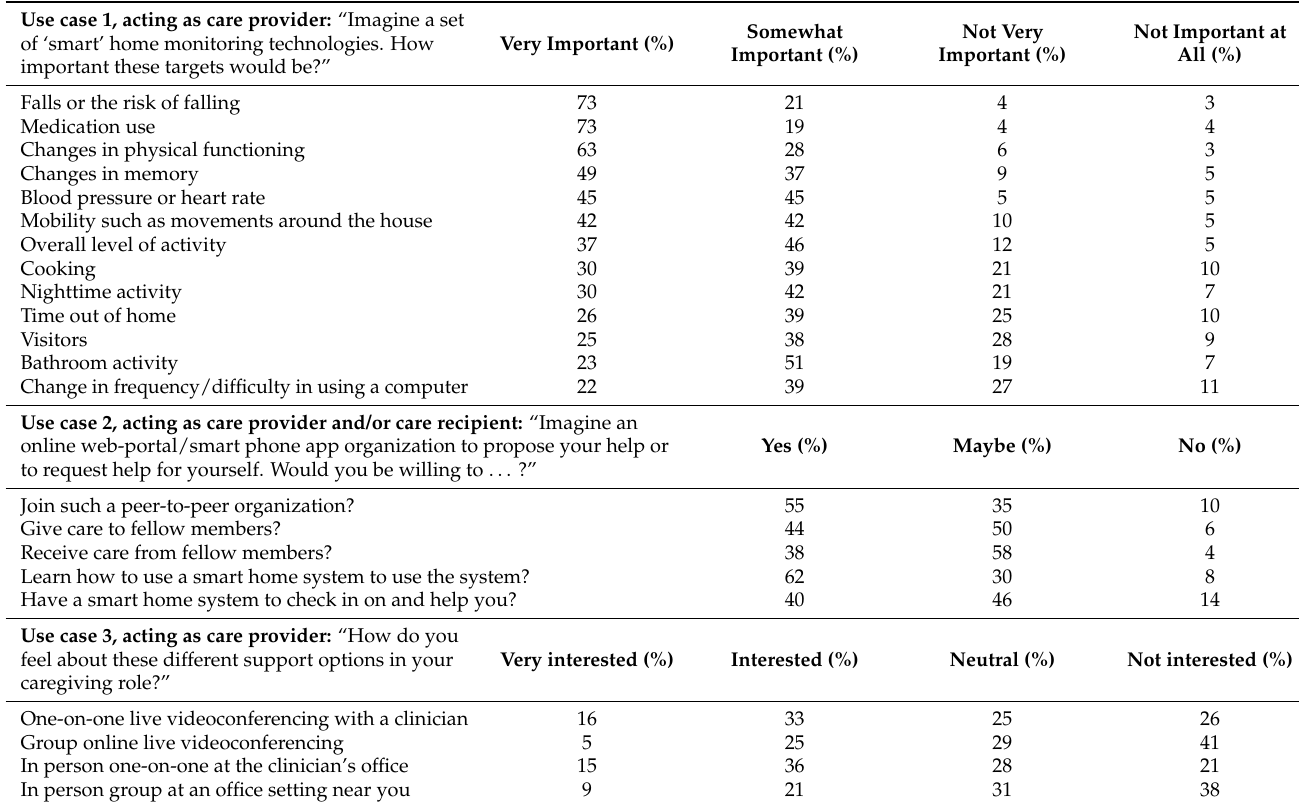
Table 4. Use cases related to technology use to support